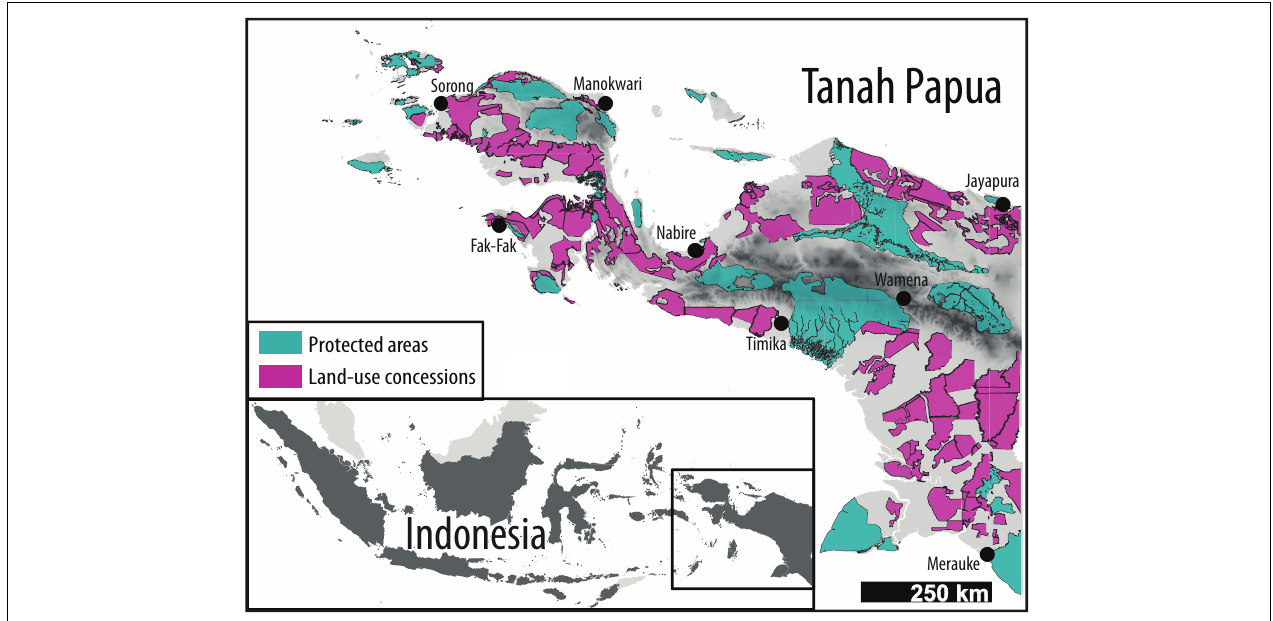
FIGURE 1 | Tanah Papua, Indonesia with protected areas (UNEP-WCMC and IUCN, 2019) and publicly available land-use concessions (Global Forest Watch, 2019). Topography is illustrated in light gray (lowest elevation) to black (highest elevation at c. 4,900 m). Protected areas represent 20% of the study area, while assessed land-use concessions comprise 29%.”